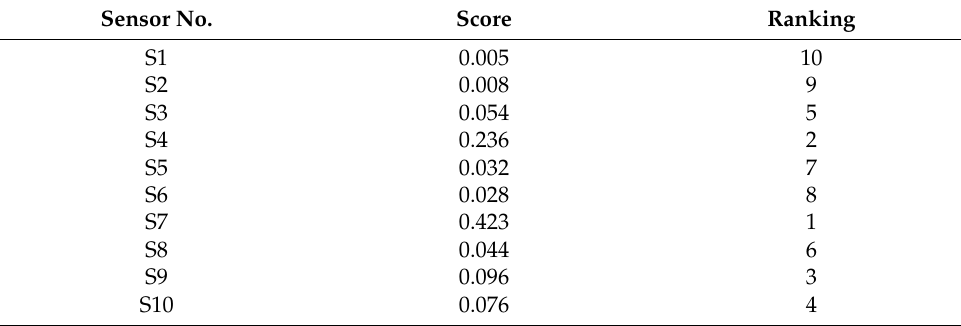
Table 5. Evaluation scores of all sensors based on the EWM-TOPSIS model. Sensor